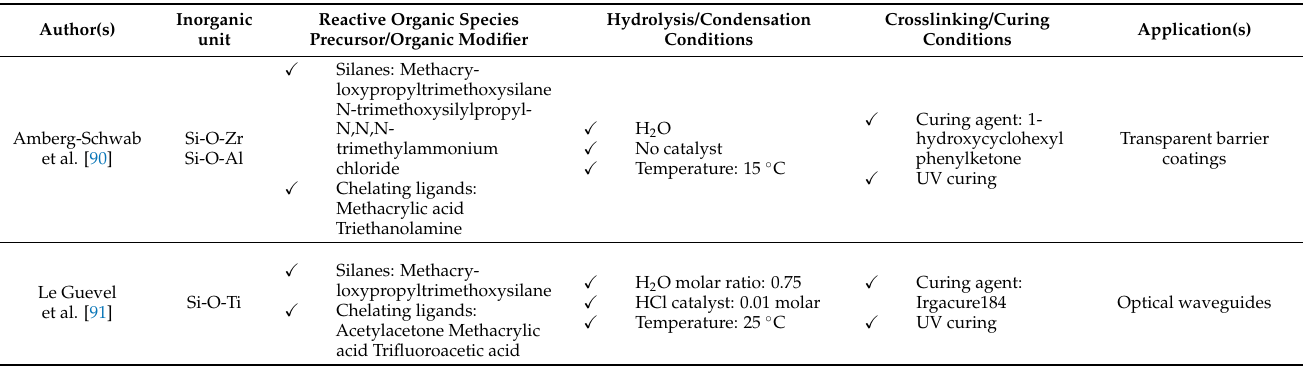
Table 2. Examples of structural elements and preparation conditions and applications of inorganic– organic hybrid polymers derived from network-forming organic chelating